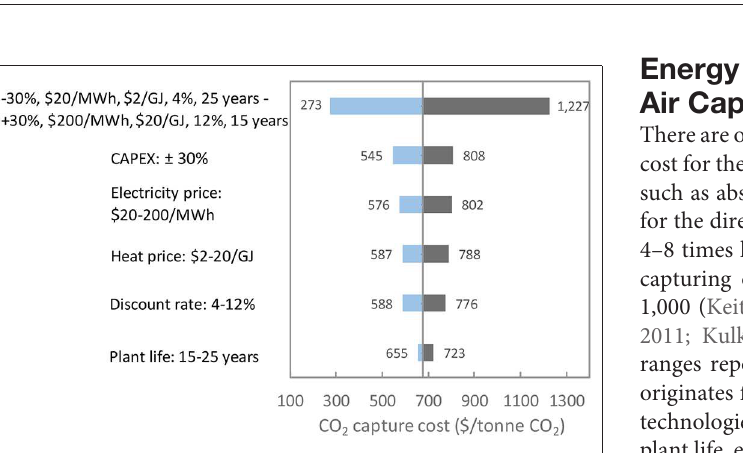
FIGURE 9 | Effect of economic variables on the CO 2 capture cost. The parameters used for the base case are: 20-year plant life, 8% discount rate, 90% capacity factor, $10/GJ heat price and $100/MWh electricity